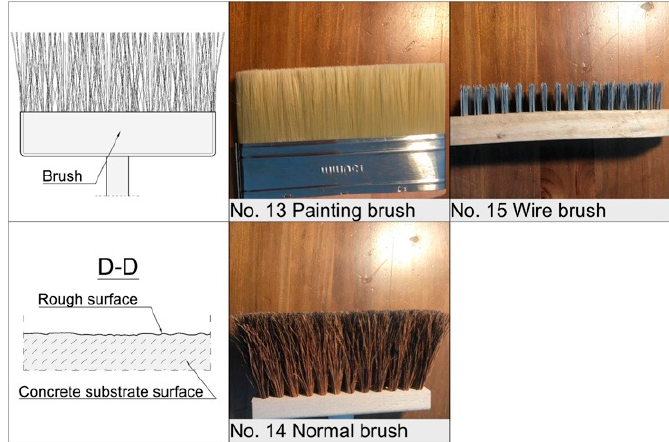
Figure 3. The applied patch grabbing method for texturing the surface of the concrete substrate (dimensions: c 1 = 2, 4, 6, 12 mm; c 2 = 1, 4, 6 mm).